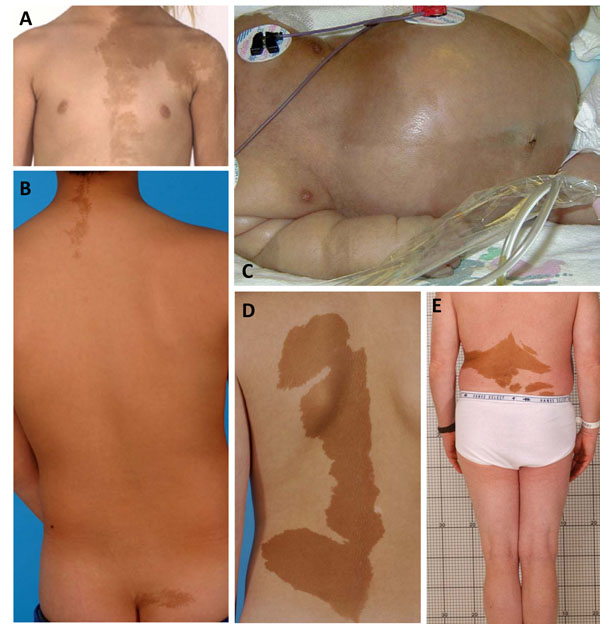
Representative Café-au-lait Spots Seen in McCune-Albright Syndrome. A spectrum of spots is shown; Panels A & B demonstrate “classic” spots that both respect the midline and display “coast of Maine” borders. Panel C shows a very unusual spot seen in a child with MAS and neonatal Cushing syndrome. While the spot respects the midline, the borders are smooth and the spots alternate from left to right in a harlequin pattern. Panel D depicts a very large spot with relatively smooth borders seen in a patient with relatively little FD. Panel E demonstrates a spot that clearly does not respect the midline.